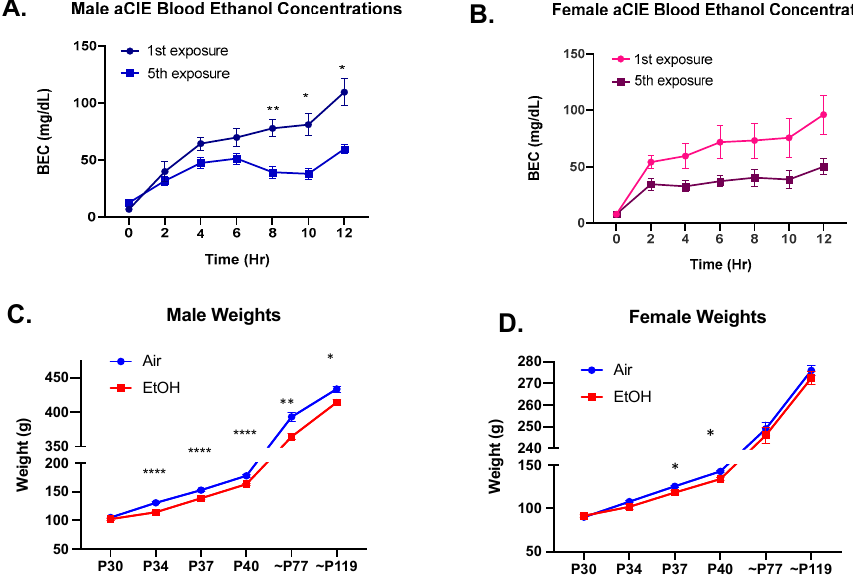
Figure 2. Blood ethanol concentration (BEC) time courses and weights. BECs over the twelve-hour adolescent chronic intermittent ethanol exposure for the first and the last exposure day for males ( A ) and females ( B ). Both males and females showed significantly lower BECs for the final exposure compared to first exposure; n = 8 per group, significant effect of exposure day denoted as * p < 0.05 and ** p < 0.01. Male ( C ) and female ( D ) weights throughout adolescent chronic intermittent ethanol exposure (P30-40) and on the first and last day of drinking sessions during adulthood (~P77 and~P119) compared between adolescent air or ethanol (EtOH) exposure. Ethanol ‐ exposed males showed significantly lower weights throughout the aCIE exposure period and at both time points in adulthood, and ethanol ‐ exposed females showed significantly lower weight on day seven and at the end of the aCIE exposure but did not show any differences in adulthood. A significant exposure effect denoted as: * p < 0.05, ** p < 0.01, and **** p < 0.0001.